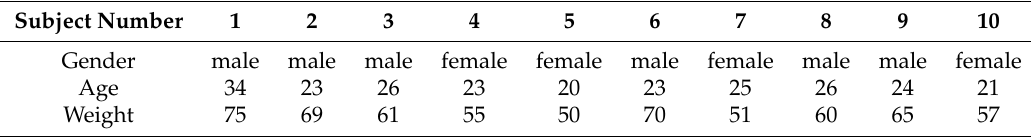
Table 3. Basic informations of subjects.